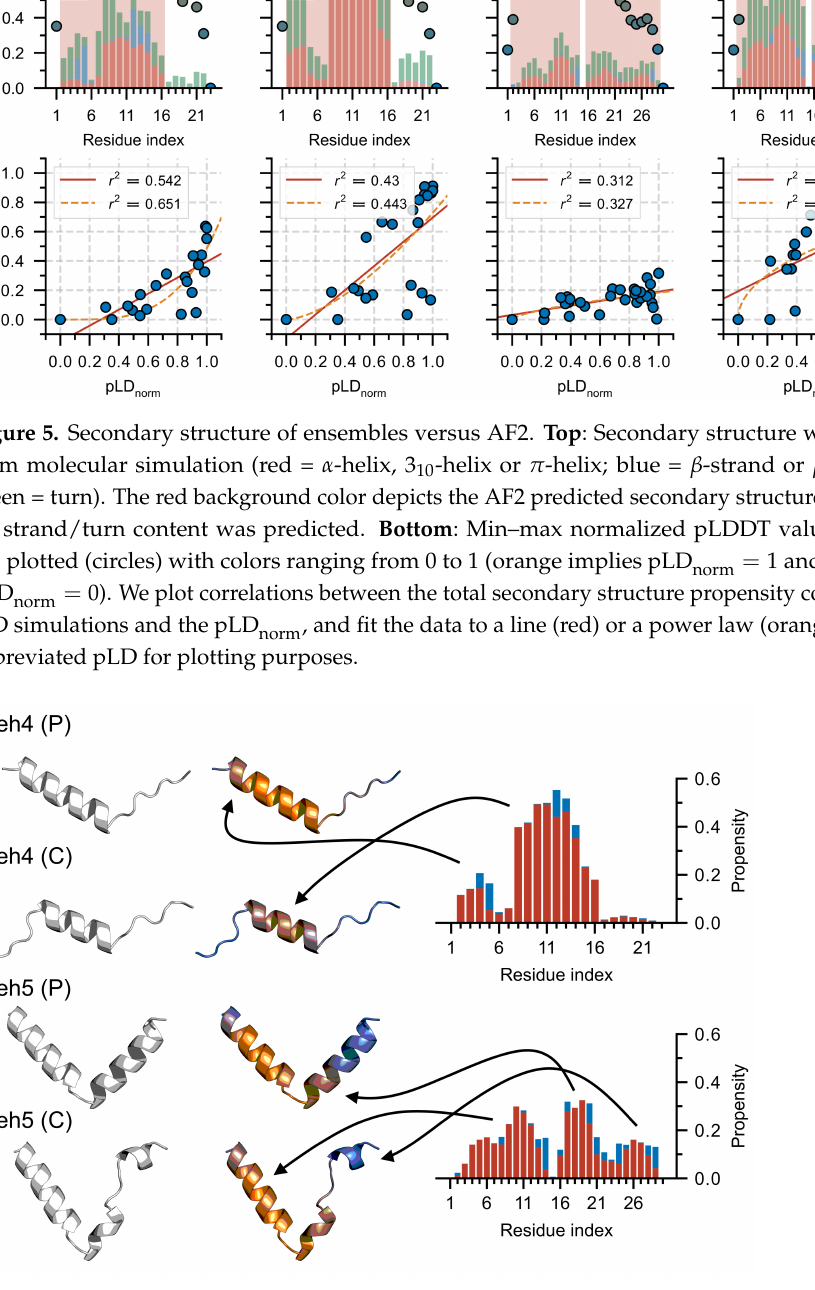
Figure 6. AF2 predicted structures correlate with simulated secondary structure. We consider the peptide (i.e., Neh4/5 (P)) and construct (i.e., Neh4/5 (C)) structures predicted from AF2, without a colormap and with a pLDDT colormap scaled between 70 and 100 (i.e., blue implies pLDDT = 70 and orange implies pLDDT = 100). Note how the coloring of the structures provides non-trivial insights that are undetectable without it. These are depicted alongside the average secondary structure computed using both the ff99SB*-ILDNP and ff99SB- disp simulations (red = α -helix, 3 10 -helix or π -helix; blue = β -strand or β -bridge). Note that arrows indicate corresponding regions between AF2 structures ( left ) and structural propensities computed from MD simulations ( right